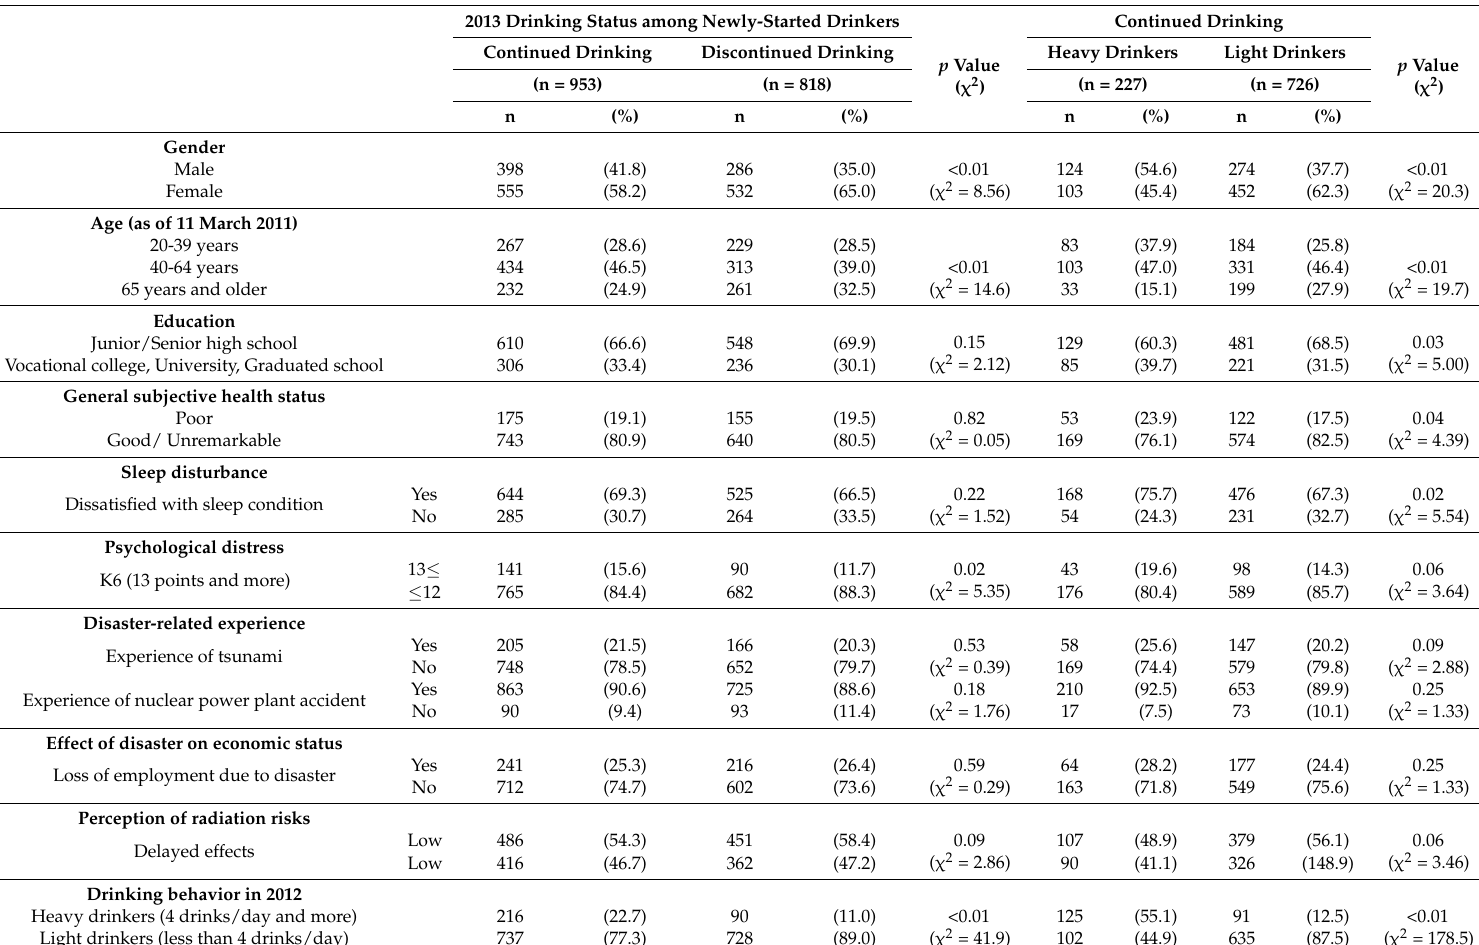
Table 4. Characteristics of newly-started drinkers who continued drinking in the 2013